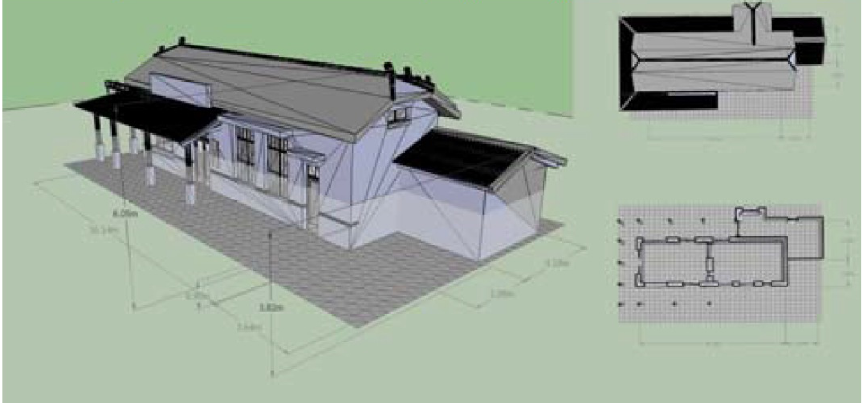
Fig. 2. 3D Documentation (Jing-Tong Train Station) (Source: H.Cheng et al.